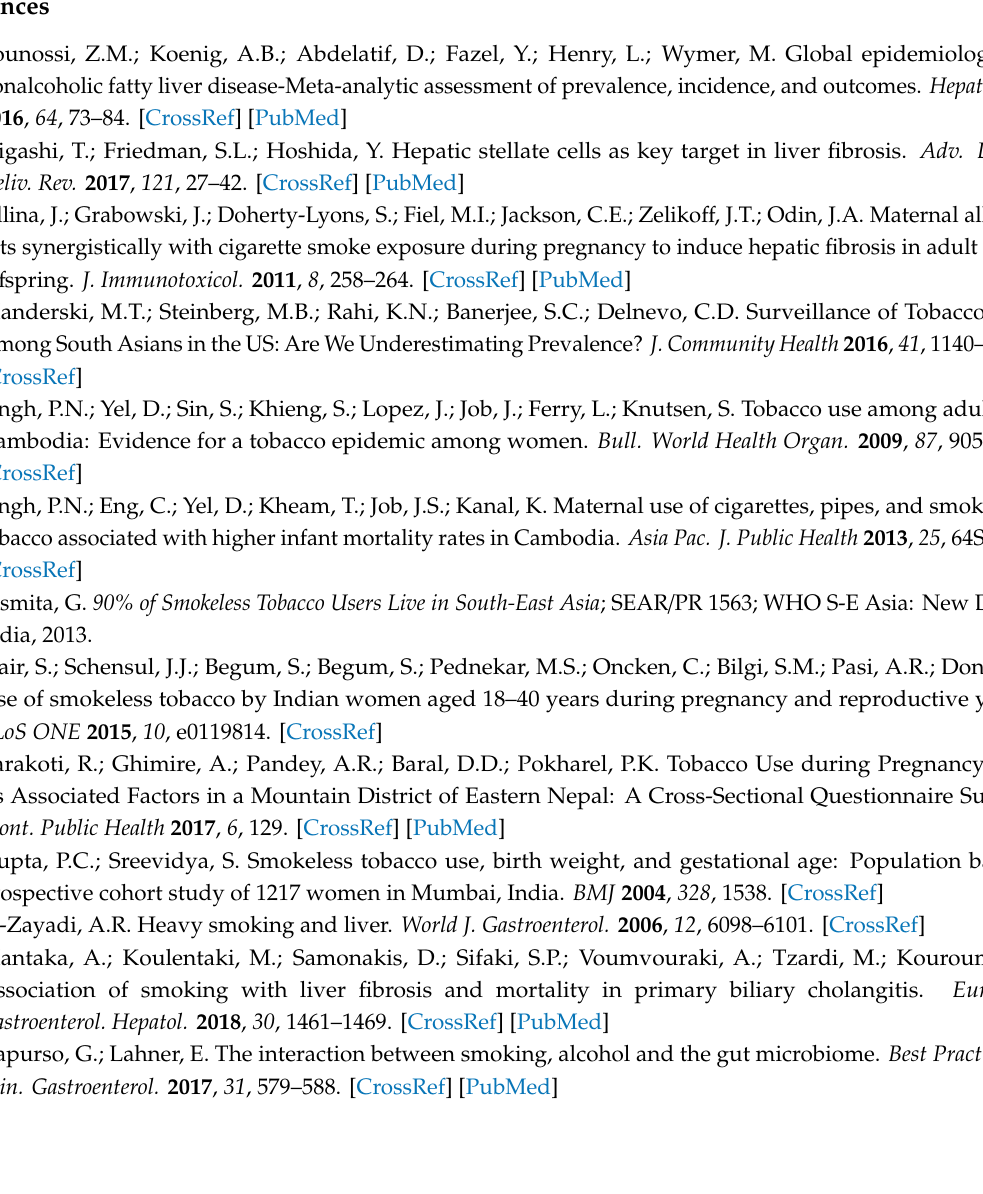
Table S1: Supplemental Table of